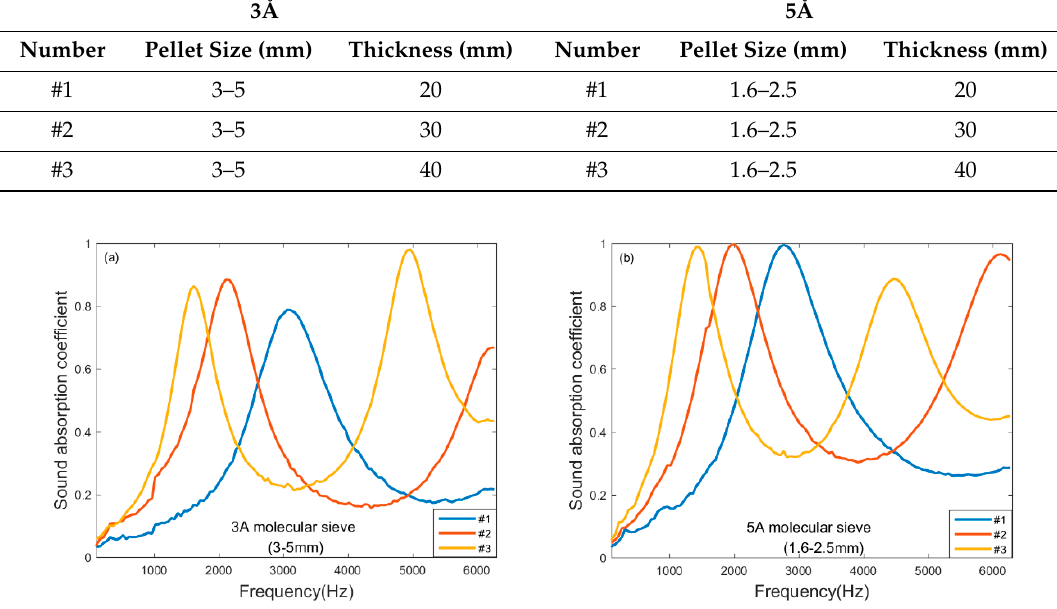
Figure 3. Sound absorption measurement of molecular sieve pellets with different thickness: ( a ) 3Å with pellet size of 3-5 mm; ( b ) 5Å with pellet size of 1.6-2.5 mm.